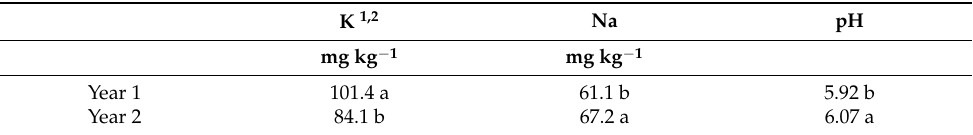
Table 7. Average soil nutrient levels over two growing seasons, across compost and fertigation treatments, in a high tunnel production of zinnia “Benary’s Giant Mix”. Data were taken 50 days after transplanting in both